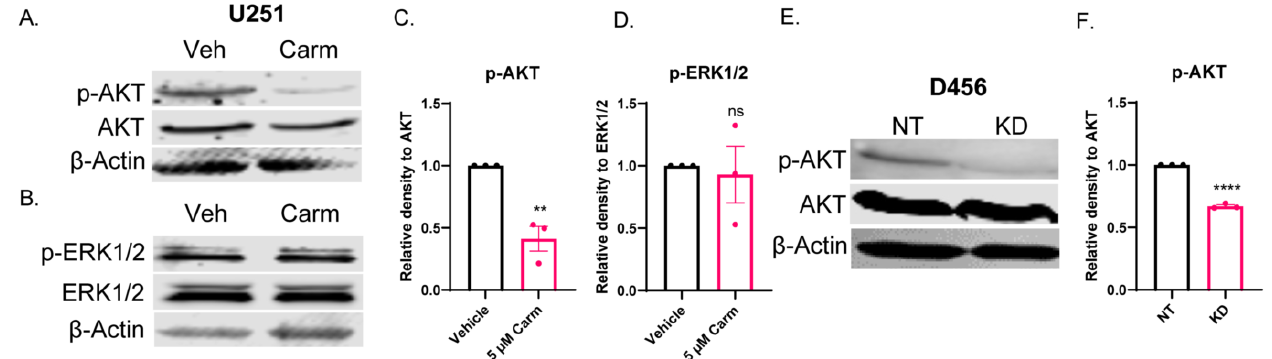
Figure 8. ASAH1 inhibition decreased pAKT, but not pERK. U251 cells were plated in 10% FBS followed by serum-starvation in the presence of vehicle (DMSO) or 5 µM carmofur for 16 h. Then, cells were stimulated with 10% FBS for 15 min followed by 45 min in the presence of fresh vehicle or carmofur. ( A , B ) Western blot expression of pAKT, AKT, pERK1/2, ERK1/2, and β -actin with carmofur treatment. ( C , D ) Densitometry values for each protein were determined using Image Studio Lite software. Quantification of densitometry values ( n = 3) for expression of pAKT compared to total AKT and pERK1/2 compared to total ERK1/2. D456 cells were transduced with either non-targeting (NT) control or ASAH1 shRNA. After 48 h of transduction, cells were serum-starved for 16 h. Then, cells were stimulated with 10% FBS for 1 h. ( E ) Western blot expression of p-AKT, AKT, and β -actin for NT and ASAH1 KD cells. ( F ) Quantification of densitometry values ( n = 3) for expression of p-AKT compared to total AKT. Data are displayed as means ± SEM. Not significant (ns), ** p < 0.01, **** p < 0.0001 with independent t -test.